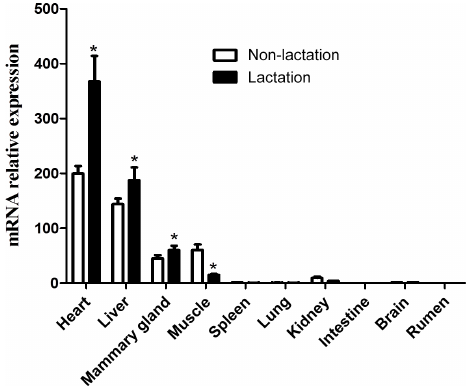
Figure 9. Tissue expression profile of buffalo DGAT2